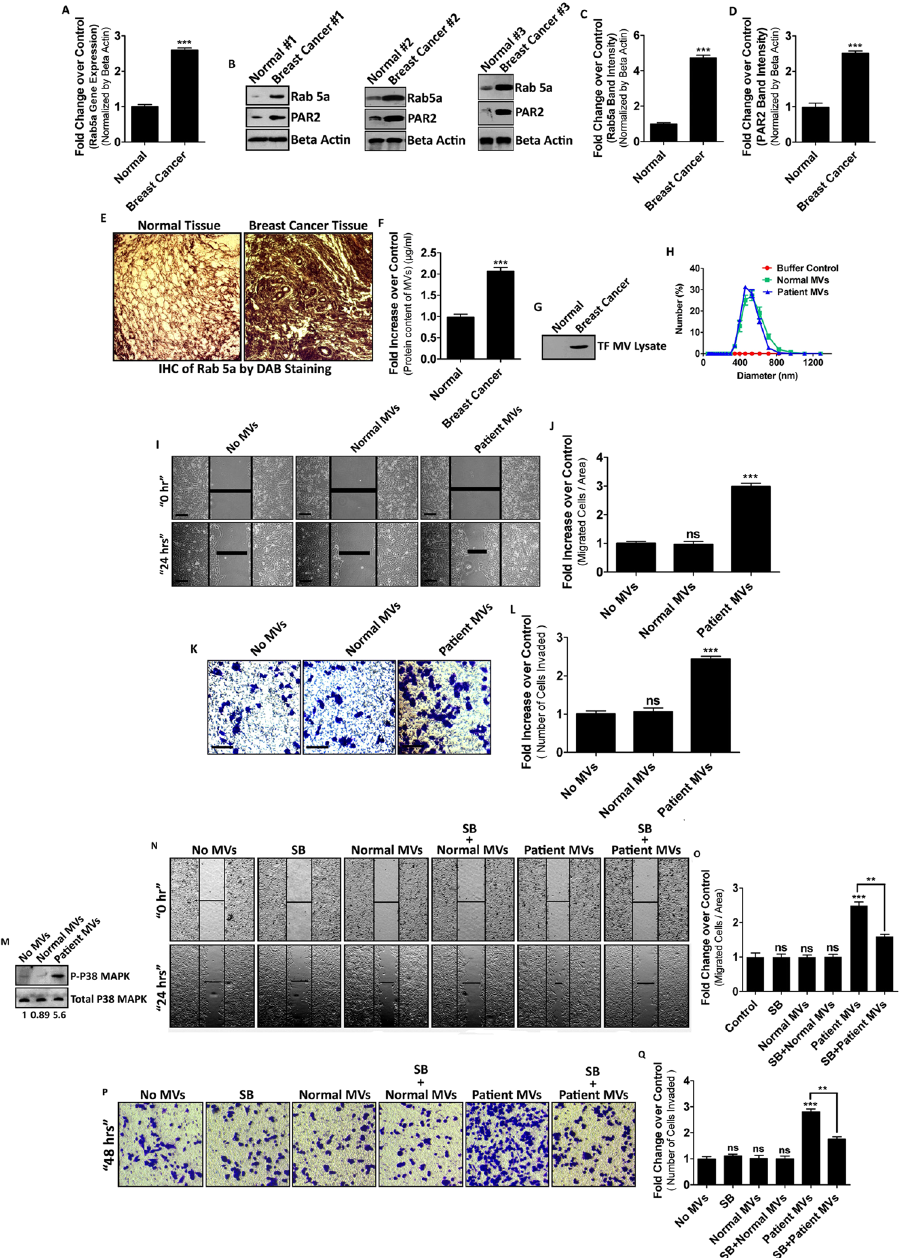
Figure 7. MVs from breast cancer patients display higher metastatic potential. Both normal as well as human breast cancer tissue samples were collected and subjected to analysis of Rab5a expression at transcription level ( A ) and protein level ( B ), ( C ) and ( E ). PAR2 protein expression was also estimated in those tissues ( B ) and ( D ). MVs were isolated from the blood of both breast cancer as well as normal individuals and quantified by Bradford assay and western blotting with TF marker ( F ) and ( G ). DLS study was performed with these MVs to determine their size ( H ). Migration ( I ) and ( J ) as well as invasive ( K ) and ( L ) potential of these blood-borne MVs was analyzed by wound healing assay and transwell invasion assay, respectively. MVs, isolated from the blood samples were fused with MCF-7 cells and p38 MAPK activation was assessed by western blotting ( M ). MCF-7 cells were treated with SB203580 for an hour followed by the addition of blood-derived MVs. Migration and invasion was checked by wound healing assay and transwell invasion assay, respectively to determine the metastatic potential of MVs ( N – Q ). The experiments were repeated at least for three times. Data presented over here are as Mean + / − S.E. of the Mean and differences are statistically significant at p < 0.05 using student’s t-test and ‘ns’ represents non-significant